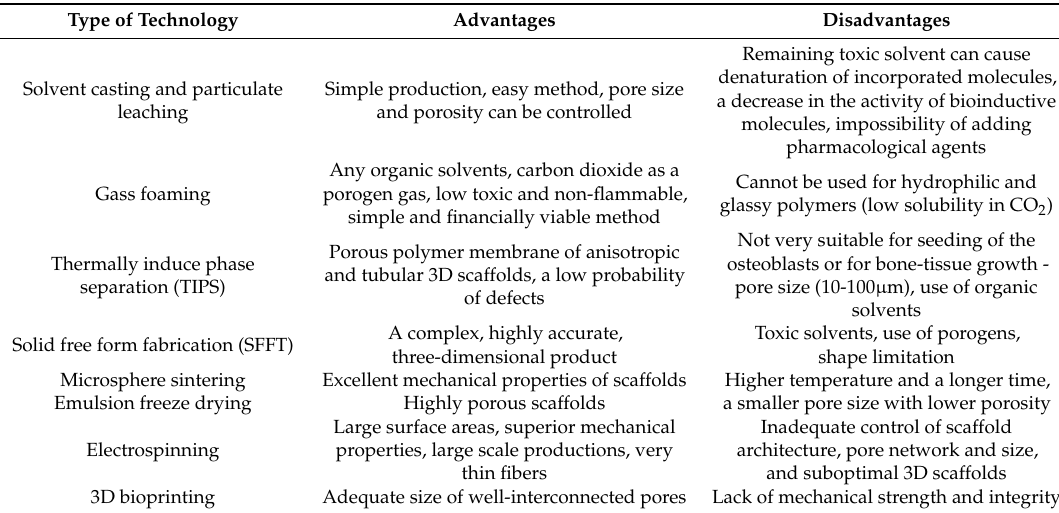
Table 5. Manufacturing technologies of